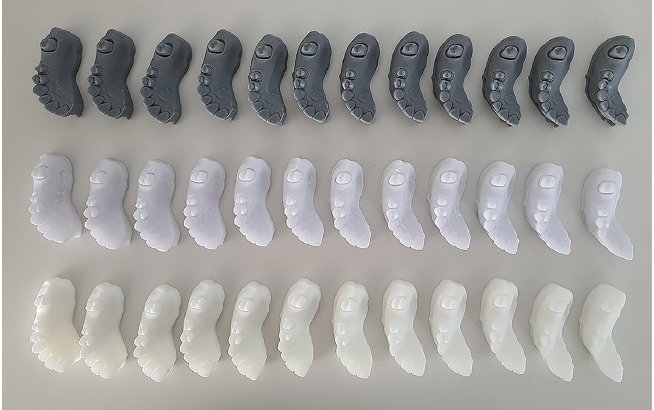
Figure 2. 3D-printed resin models ( n = 36) of this study. First row; DLP models, second row; MJP models; third row; SLA models. Table 1. Specifications of the 3D printer and materials used in this study.